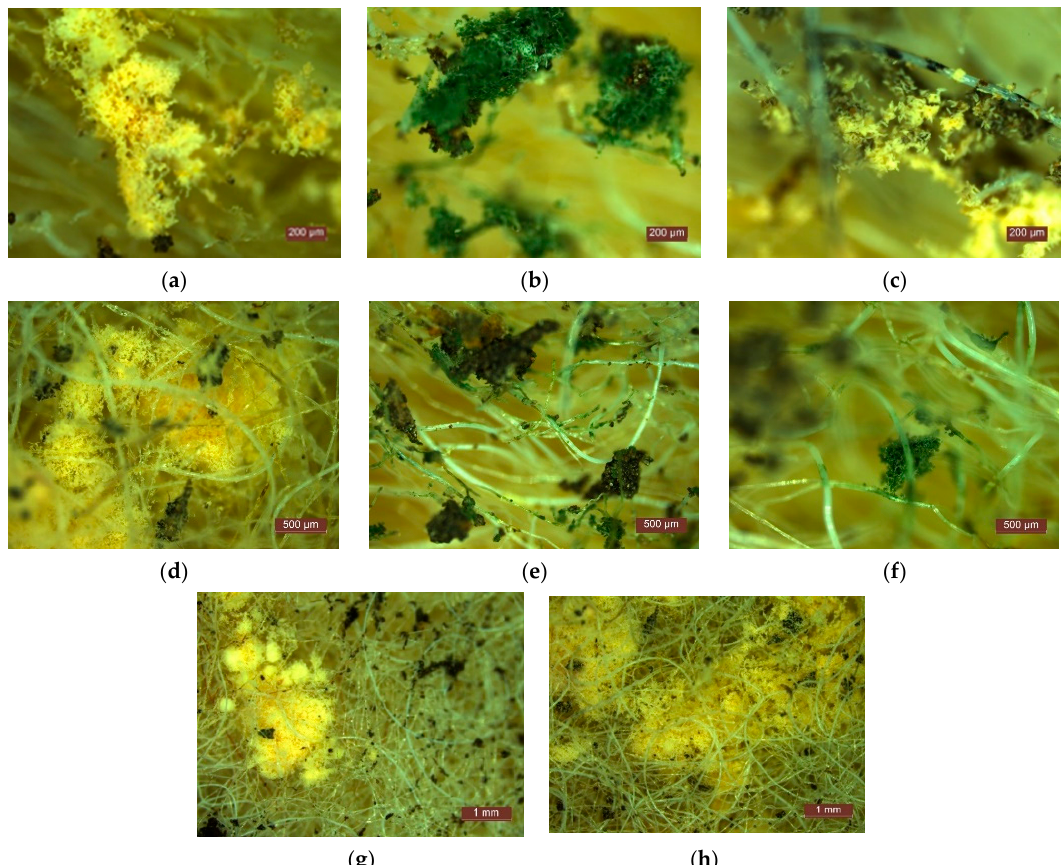
Figure 6. Instances regarding the microscopic analysis of test specimens by holding in soil for one month ( a – h ).